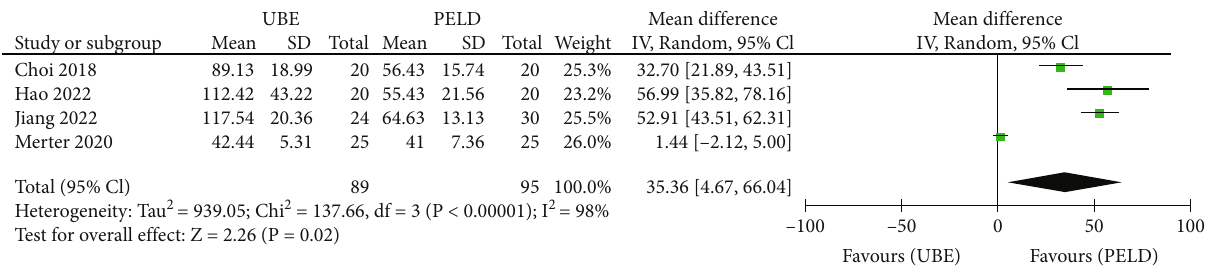
Figure 2: Forest plot of UBE and PELD on operative time.